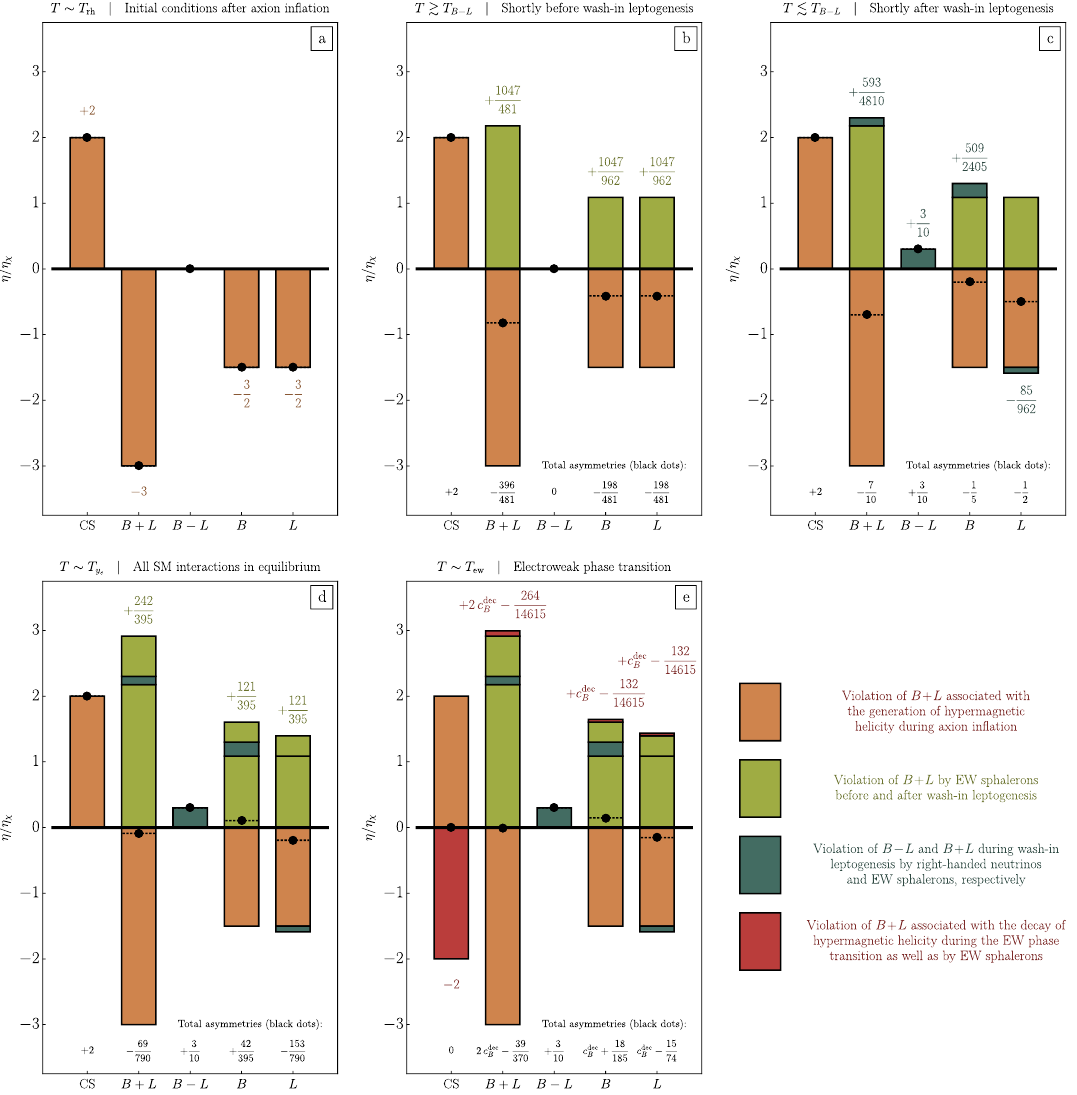
Figure 2 . Evolution of the global CS, B + L , B − L , B , and L charges in the benchmark scenario discussed in section 4 all the way from the end of axion inflation to the EWPT. Panels (a) and (b) describe the initial conditions after axion inflation and the chemical equilibrium shortly before wash-in leptogenesis (see section 4.1); panels (c), (d), and (e) illustrate the situation shorty after wash-in leptogenesis, below the equilibration temperature of the electron Yukawa interaction, and at the time of sphaleron freeze-out towards the end of the EWPT (see section 4.2). The red bars in panel (e) indicate the outcome of baryogenesis from helicity decay (see section 4.3). Every panel contains the bars shown in all previous panels plus new bars that indicate the relevant new contributions to the respective charges. The total charges at the respective stages of the evolution are indicated by the black dots and horizontal black dashed